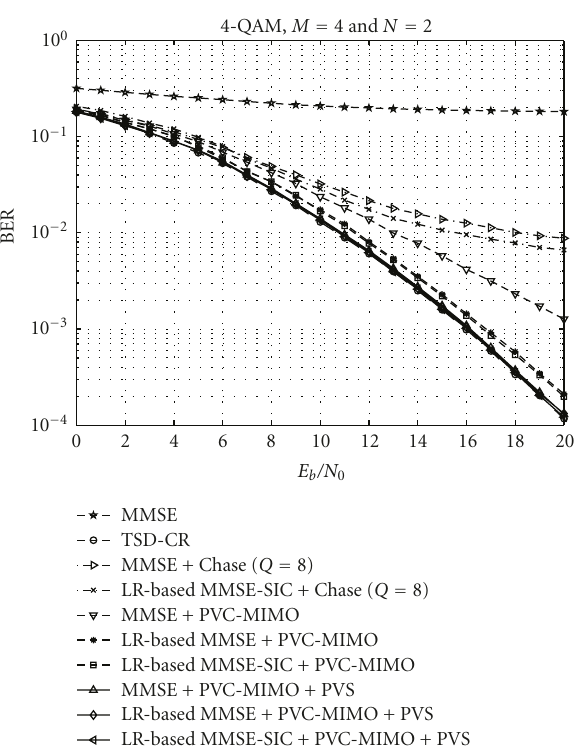
Figure 1: BER versus E b /N 0 of di ff erent detectors represented in Section 5.1 for 4-QAM, M = 4, N = 2.